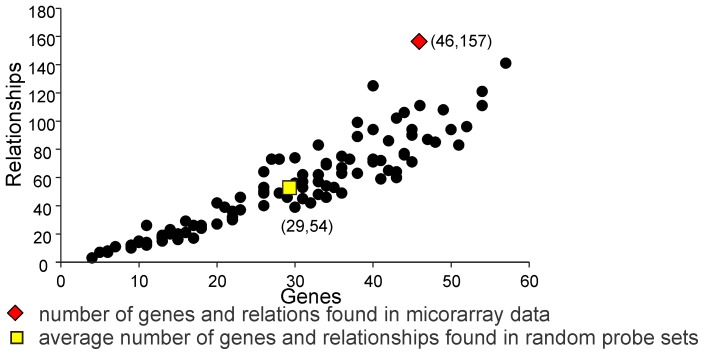
Comparison of complexity of relationship networks generated for the DEG’s list and 100 random probe set lists of the same size.Total number of entities and relationships present in the largest network generated for a list were used to construct the graph. Circles represent random probe set lists, yellow square represents the average for 100 random list networks and the red diamond represents the DEG list. The red triangle shows the value of entities versus relationships found from our gene list. The Z score for this value in relation to average (yellow square) was 12.5 (p<0.01).